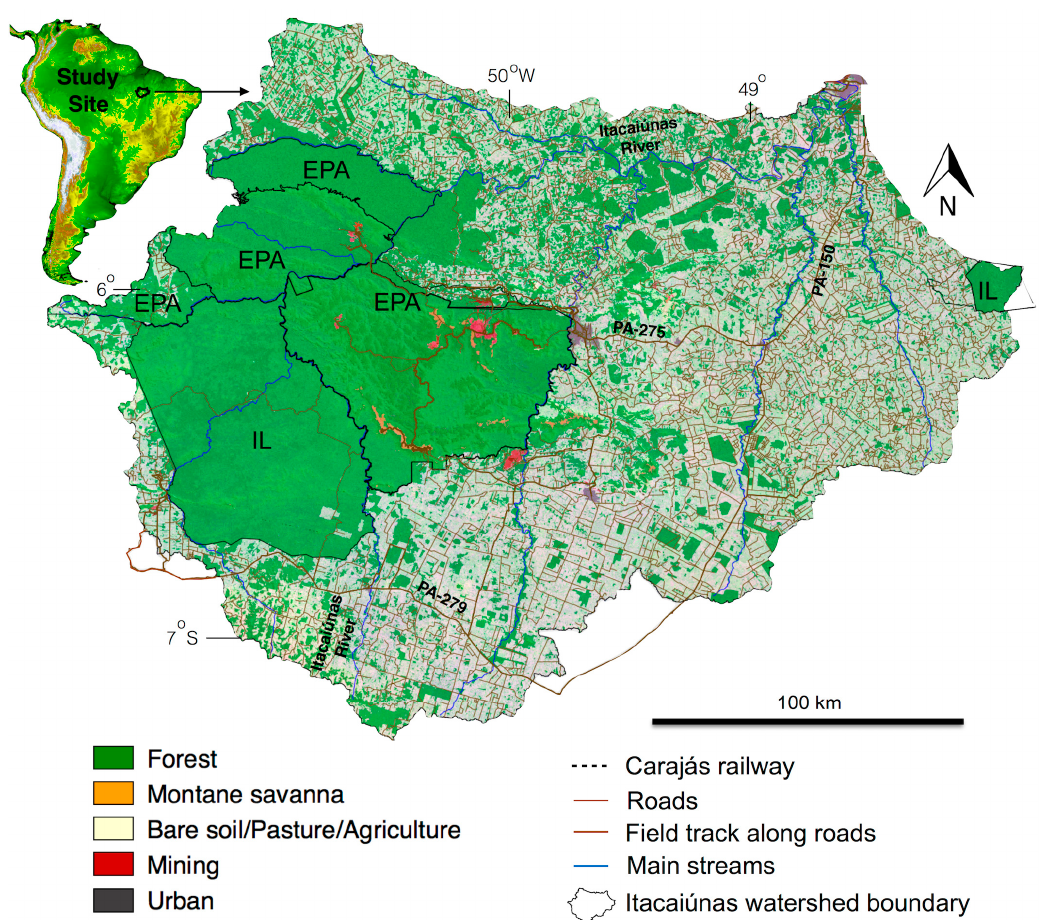
Figure 1. Map of the study area on the 2013 LCLU map generated from an interpretation of Landsat-8 OLI mosaic images. IL = indigenous lands; EPA = environmental protected areas.